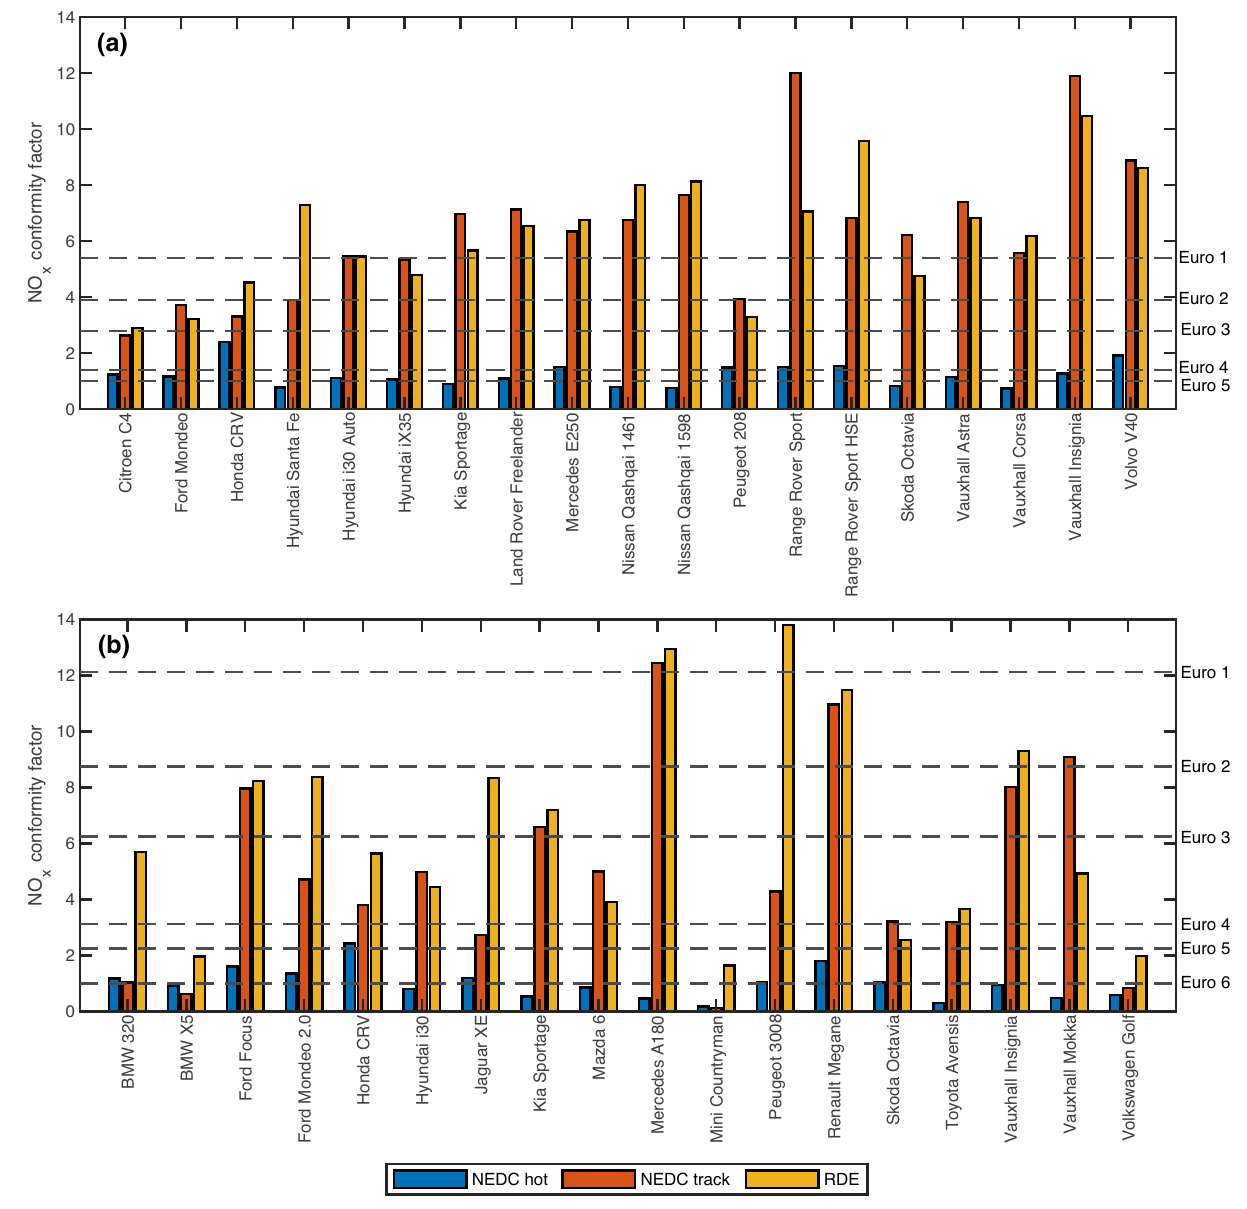
Figure 1. NO x conformity factors of tested vehicles in NEDC hot, NEDC track and RDE tests. ( a , b ) Euro 5 vehicles ( a ), Euro 6 vehicles ( b ). The conformity factor is defined as the ratio of the recorded NO x emission rate to the Euro limit of the vehicle. A factor value of 1 implies that the vehicle is abiding towards the emission limit. Bar heights represents the conformity factor values, and dashed lines represent the limits from Euro 1 to Euro 6 (note that the true Euro 1 and Euro 2 limits includes NO x and unburnt hydrocarbons emissions). The number of vehicles that failed to meet the different Euro limits in RDE testing are as follow: For ( a ) —Euro 1: 13, Euro 2: 16, Euro 3 and above: 19. For ( b ) —Euro 1: 2, Euro 2: 4, Euro 3: 8, Euro 4: 14, Euro 5: 15, Euro 6: